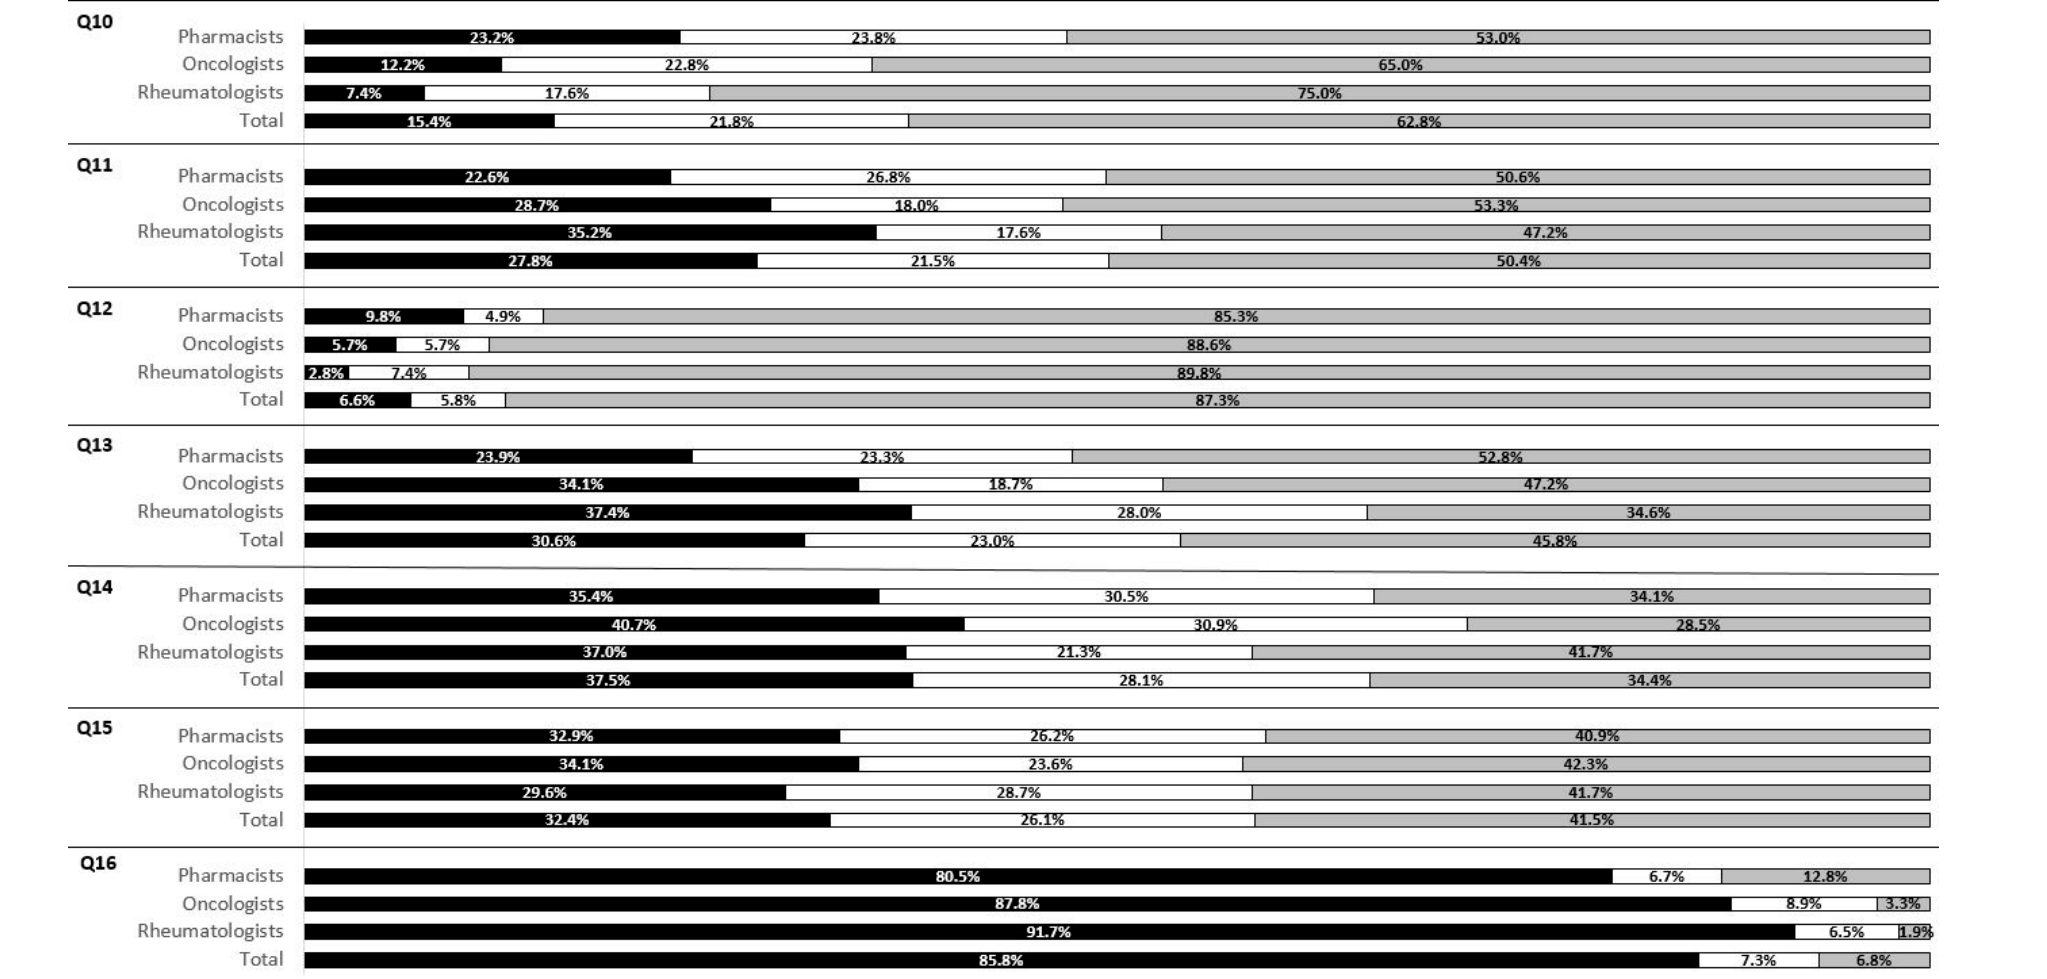
Figure 2. Respondents’ attitudes toward biosimilars by professions.